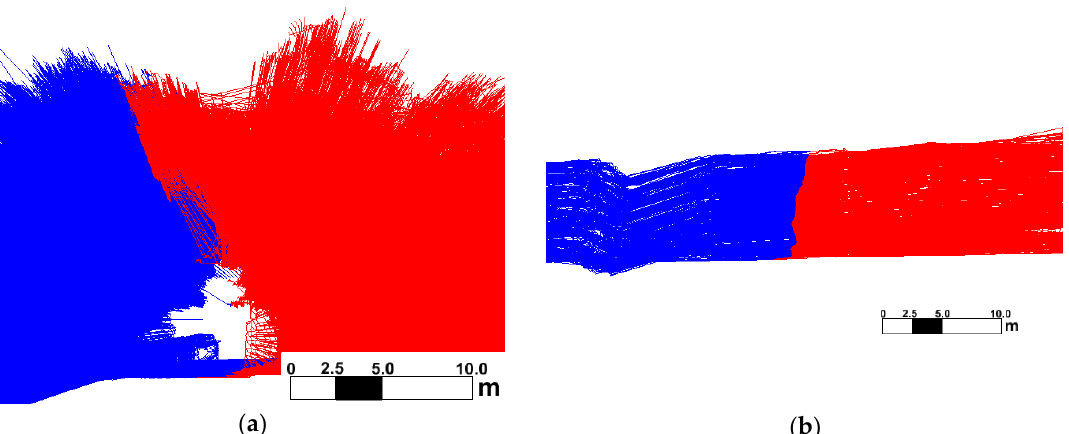
Figure 7. Trajectory distance versus GPS epoch point filter: ( a ) original TCS resulting from the cloud decomposition and ( b ) result after the filter application.